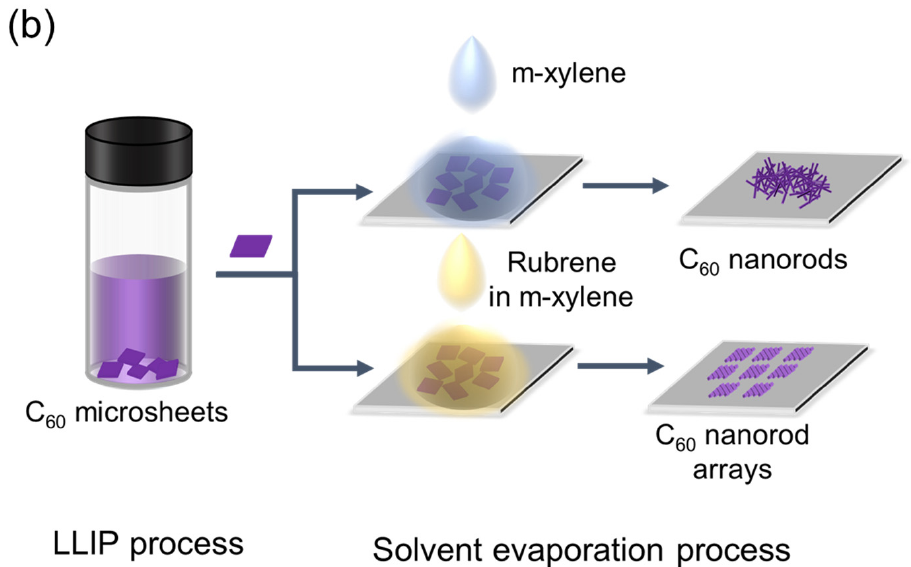
Figure 1. ( a ) Molecular structures of C 60 and rubrene. ( b ) Schematic illustration of the fabrication processes of C 60 nanorods and C 60 nanorod arrays.